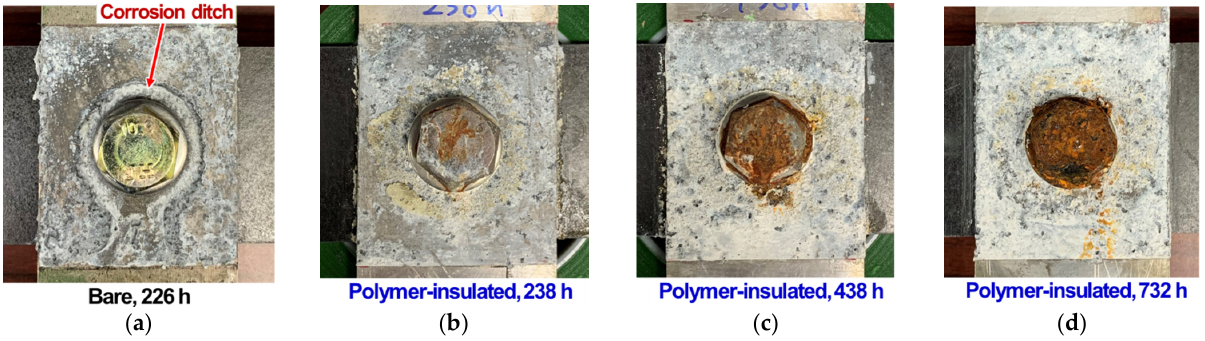
Figure 7. Cross-tension bolted joints after salt spray exposure presented for ( a ) bare and ( b – d ) polymer-insulated conditions. The exposure time is designated for each specimen.